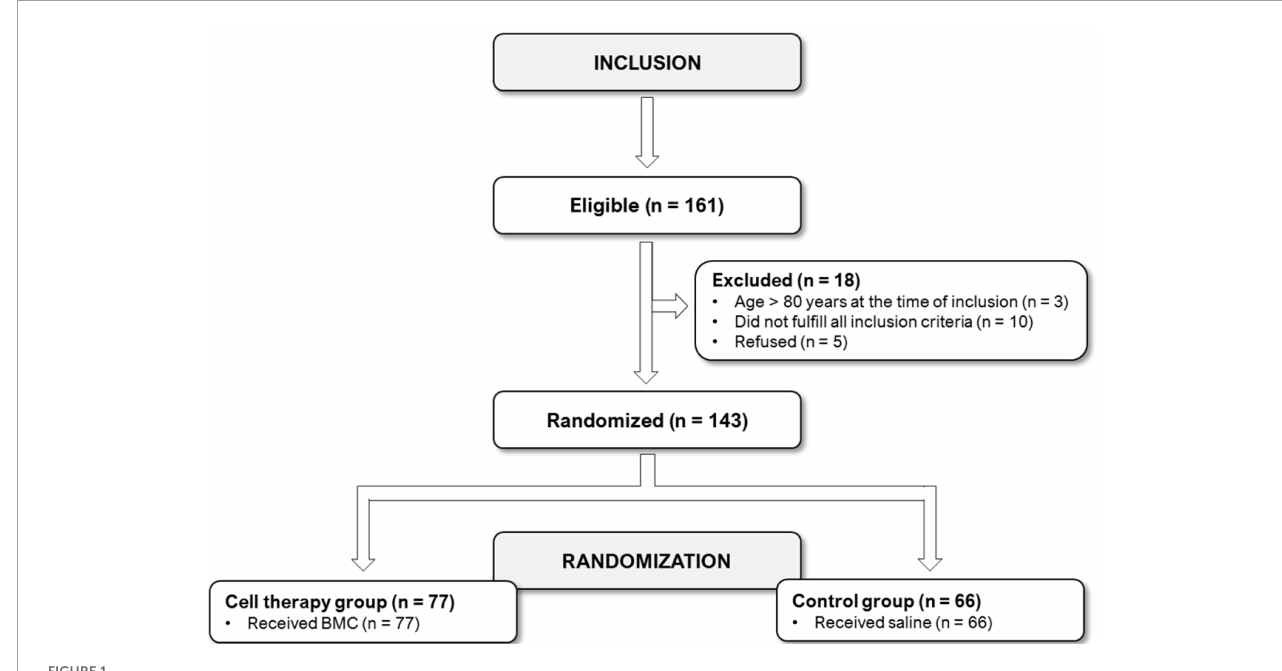
FIGURE1 Patient’s